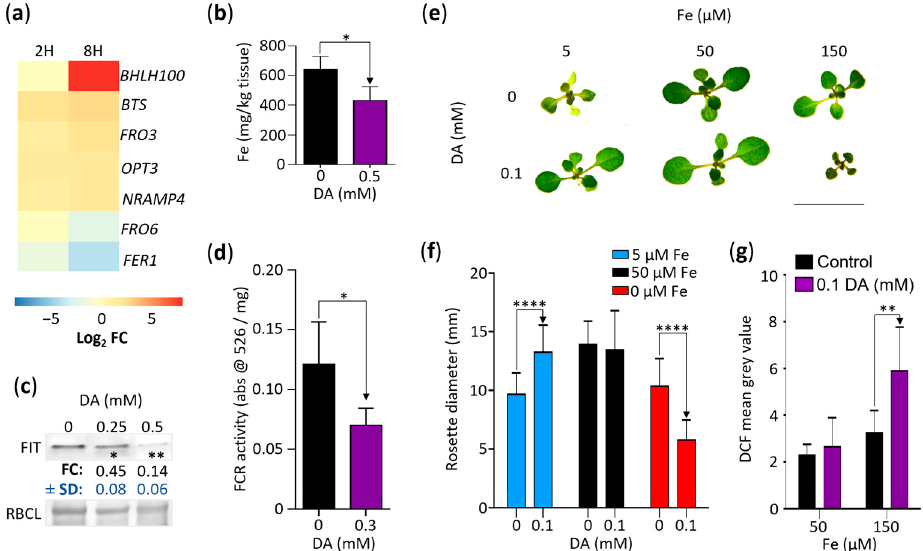
Figure 8. DA impacts iron homeostasis and generates elevated oxidative stress in the presence of high iron. ( a ) DA alters the expression of several iron-homeostasis-associated genes. Gene-level expression data were generated as described in the Materials and Methods. Iron-homeostasis-associated genes were extracted and are presented as a heatmap of log2 fold changes (Log2 FC) at 2 (2H) and 8 (8H) hours. All presented DEGs with a non-zero log2 FC have an FDR < 0.0001. ( b ) Plants grown on DA-supplemented media accumulate less iron. Col-0 seedlings grown for 7 days on control media and 0.5 mM DA were analyzed using ICP-MS ( n = 3 pools of seedlings; * represents p < 0.05, Student’s t -test). ( c ) DA represses the accumulation of FIT. Col-0 seedlings grown on MS/2 media supplemented with the denoted concentrations of DA for 7 days were used for immunoblotting analyses with anti-FIT antibodies. Representative immunoblot and the accompanying Ponceau S-stained membrane are shown (RBCL; large subunit of RuBisCO). Signal density was measured using ImageJ software, and fold change (FC) compared to the control ± SD is presented below the blots. ( n = 3; * represents p < 0.05; ** represents p < 0.01; paired one-way ANOVA on raw density data with Dunnett’s post-test). ( d ) DA-induced inhibition of ferric chelate reductase activity. Col-0 plants were grown for 12 days on MS/2 media supplemented with 0 or 0.3 mM DA. A total of ~10 mg of roots was excised and submerged in ferric chelate reductase (FCR) assay solution. After 25 min, the absorbance was measured at 526 nm. Data are presented as mean ± SD ( n ≥ 5; * represents p < 0.05; one-way ANOVA with Tukey’s post-test; comparisons are marked with one-way arrows). ( e ) Iron availability modulates the DA-induced inhibition of rosette growth. Col-0 seedlings grown for 14 days on iron-depleted media containing the denoted concentrations of DA and Fe-EDTA (Fe) were transferred to fresh plates and were photographed. Scale: 10 mm. ( f ) Quantification of the rosette diameter of plants grown as described in ( e ). Plants were photographed and rosette diameter was measured using ImageJ. Data are presented as mean ± SD. ( n ≥ 30; **** represents p < 0.0001; one-way ANOVA with Tukey’s post-test; comparisons are marked by one-way arrows). ( g ) Quantitative analysis of the influence of iron content in media on DA-induced ROS accumulation. Col-0 seedlings grown for 7 days on MS/2 media supplemented with the denoted concentrations of DA and Fe-EDTA were submerged in 10 µ M H2DCF-DA and incubated at room temperature in complete darkness for 15 minutes. DCF was visualized using fluorescence microscopy. Mean grey value of DCF fluorescence was measured in 1.5 mm of root tissue (basipetal from root tip). Data are presented as mean ± SD. ( n ≥ 9; ** represents p < 0.01; one-way ANOVA with Tukey’s post-test; comparisons are demarked by one-way